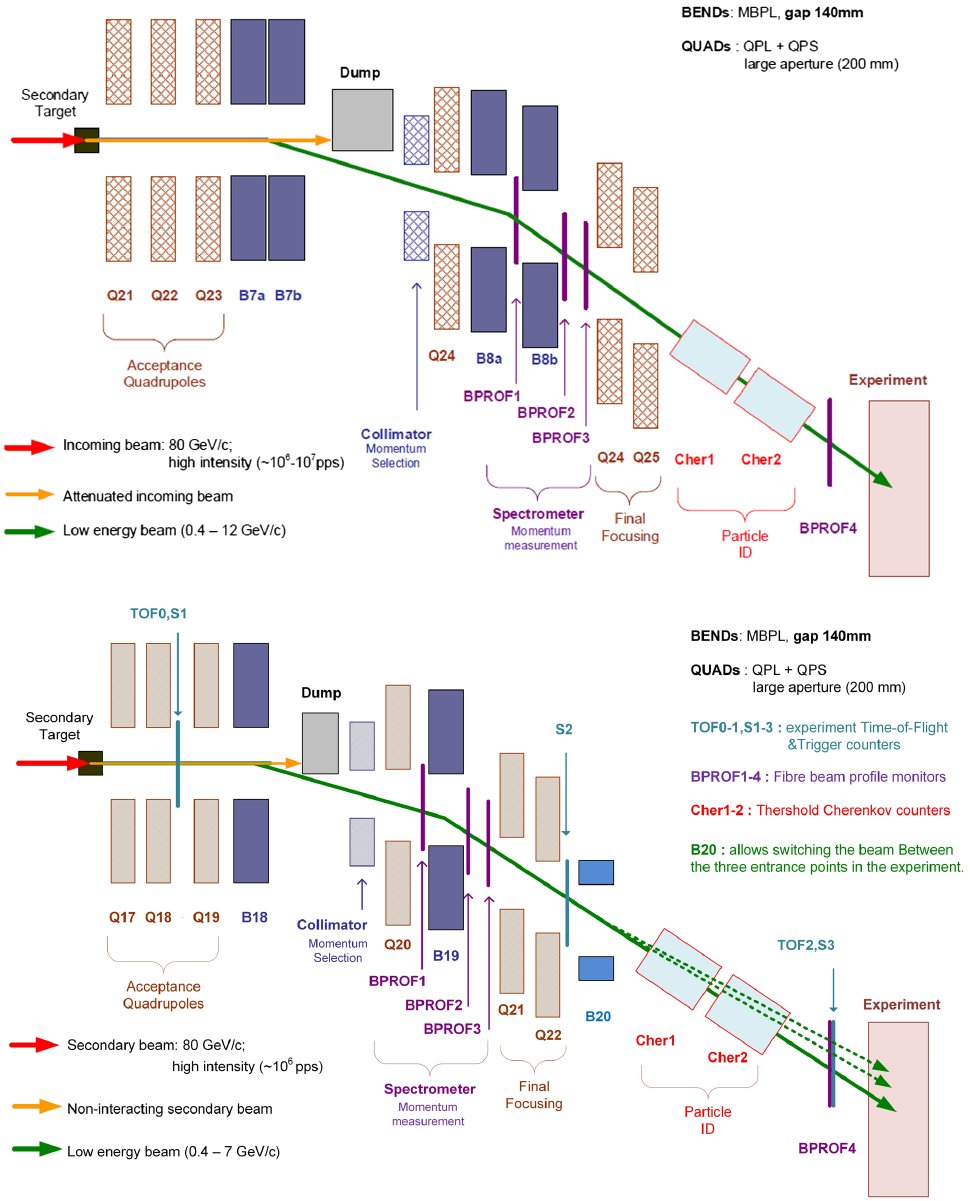
FIG. 4. Schematic layout of the H2-VLE (top) and H4-VLE (bottom) beam lines, showing the magnetic elements and the proposed beam